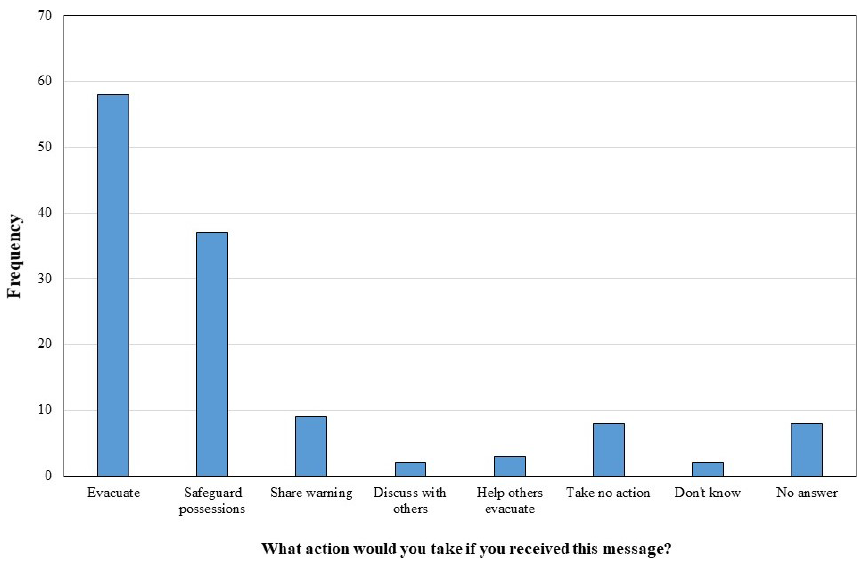
Figure 11. Actions that community-level respondents would take on receiving an SMS.